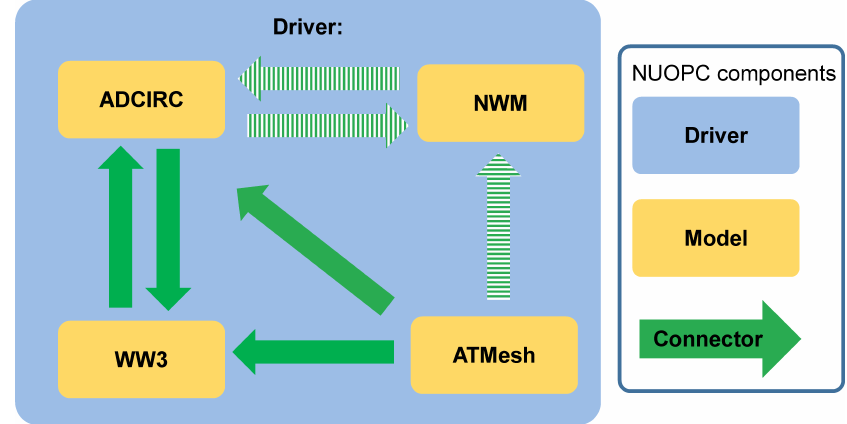
Figure 1. Design of the coupled application for coastal flooding inundation studies ( NSEM ). All model configurations and results are pre-decisional and for official use